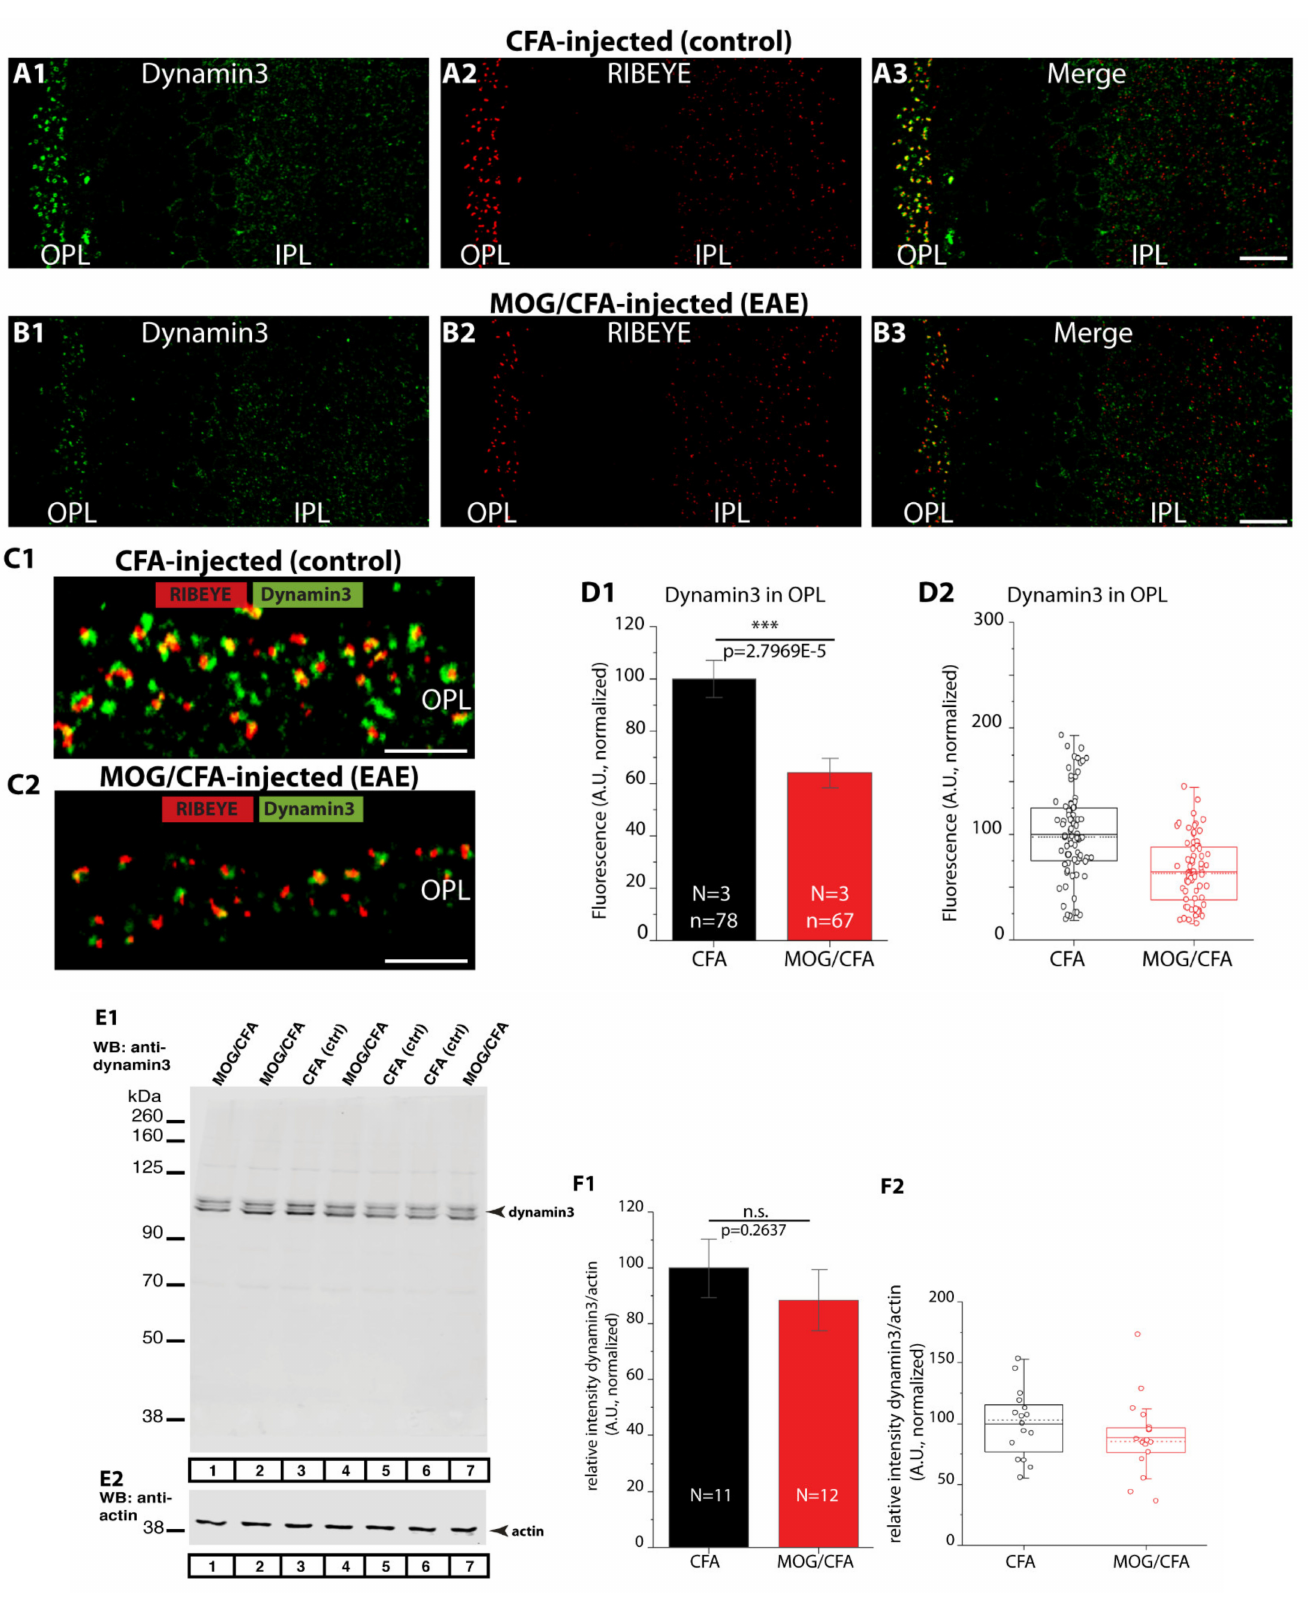
Figure 9. Decreased enrichment of dynamin 3 to photoreceptor synapses in the OPL of MOG/CFA-injected early EAE mice. ( A1 – C2 ) Semi-thin retina sections from CFA- and MOG/CFA-injected mice obtained on day 9 after injection were double-immunolabelled with anti-dynamin 3 and anti-RIBEYE antibody, as indicated. ( C1 , C2 ) Magnified views of the